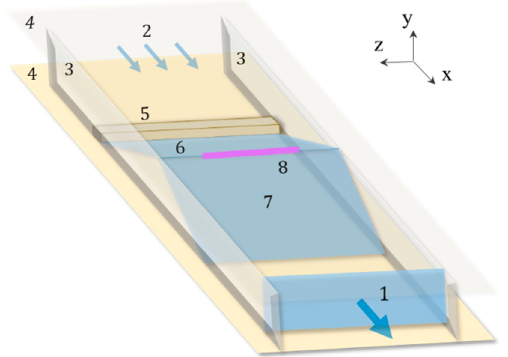
Figure 2. Schematic of a shock wave pattern in the discharge chamber: (1) initial plane shock wave; (2) co-current flow direction; (3) quartz glass; (4) dielectric surface; (5) obstacle; (6) oblique shock wave; (7) reflected shock wave; (8) discharge channel.